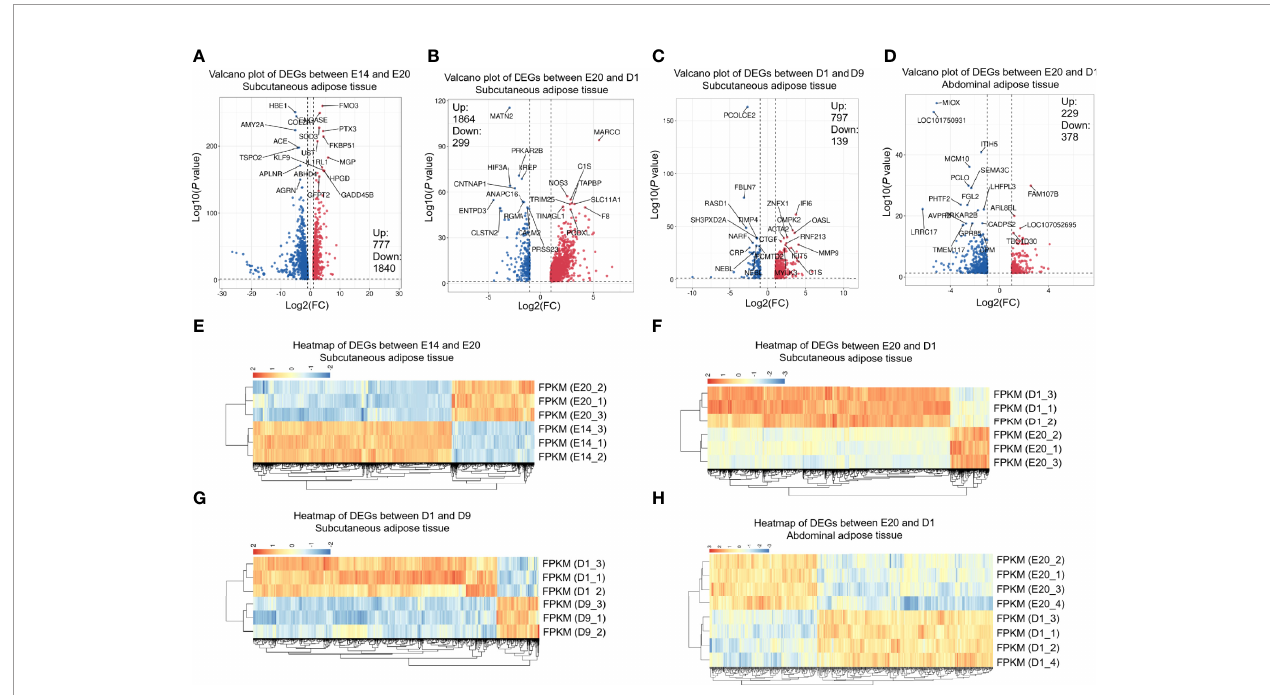
FIGURE 2 | DEGs between different development stages of chick subcutaneous adipose tissue and abdominal adipose tissue. (A) Volcano of DEGs between E14 and E20 in chick subcutaneous adipose tissue; (B) volcano of DEGs between E20 and D1 in chick subcutaneous adipose tissue; (C) volcano of DEGs between D1 and D9 in chick subcutaneous adipose tissue; (D) volcano of DEGs between D1 and D9 in chick abdominal adipose tissue; (E) heatmap of DEGs between E14 and E20 in chick subcutaneous adipose tissue; (F) heatmap of DEGs between E20 and D1 in chick subcutaneous adipose tissue; (G) heatmap of DEGs between D1 and D9 in chick subcutaneous adipose tissue; (H) heatmap of DEGs between E14 and E20 in chick abdominal adipose